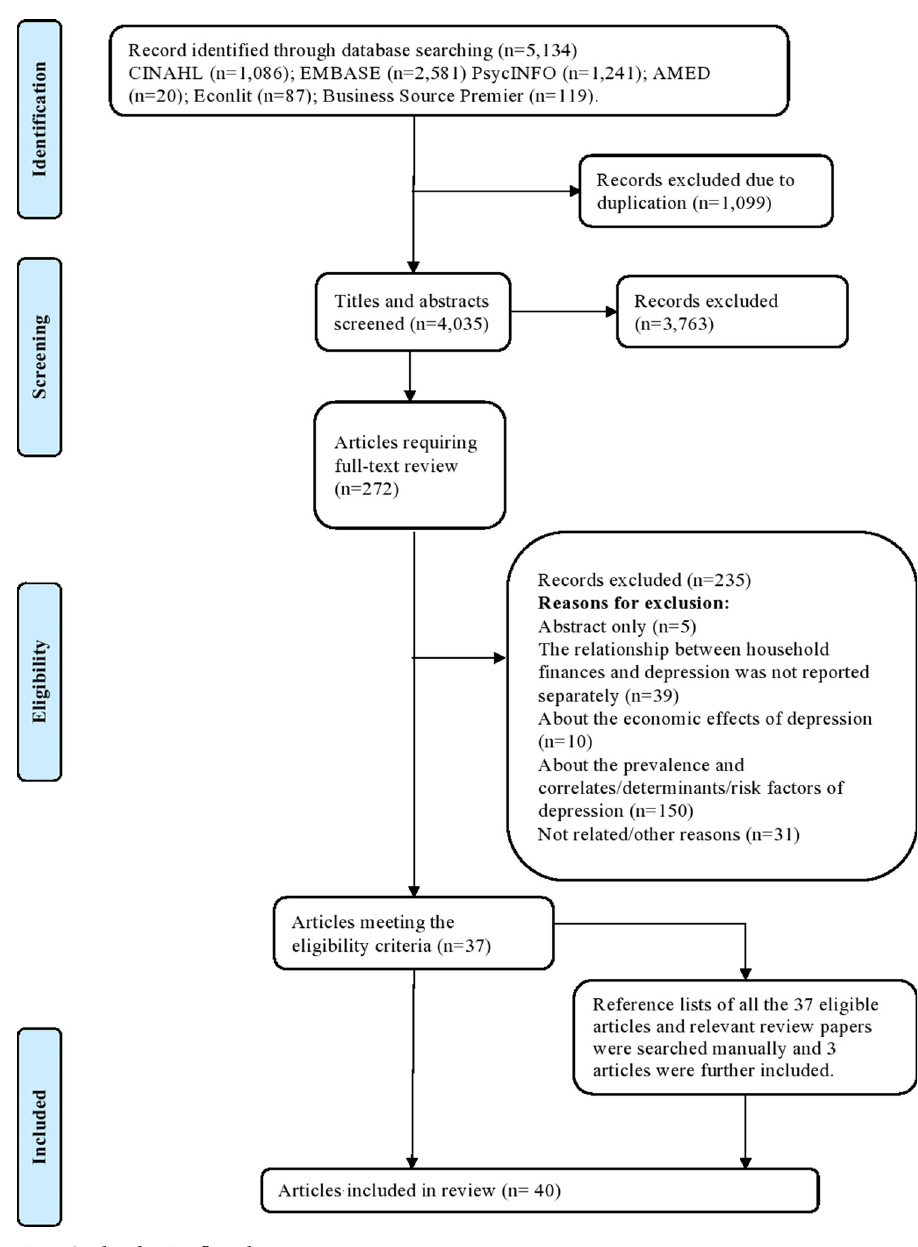
Fig 1. Study selection flow